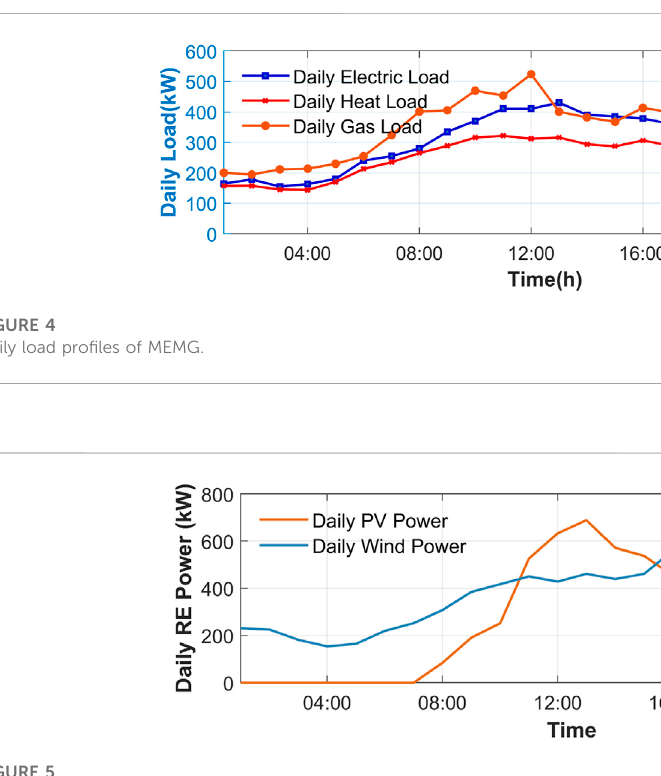
FIGURE 5 Daily RE power of MEMG.